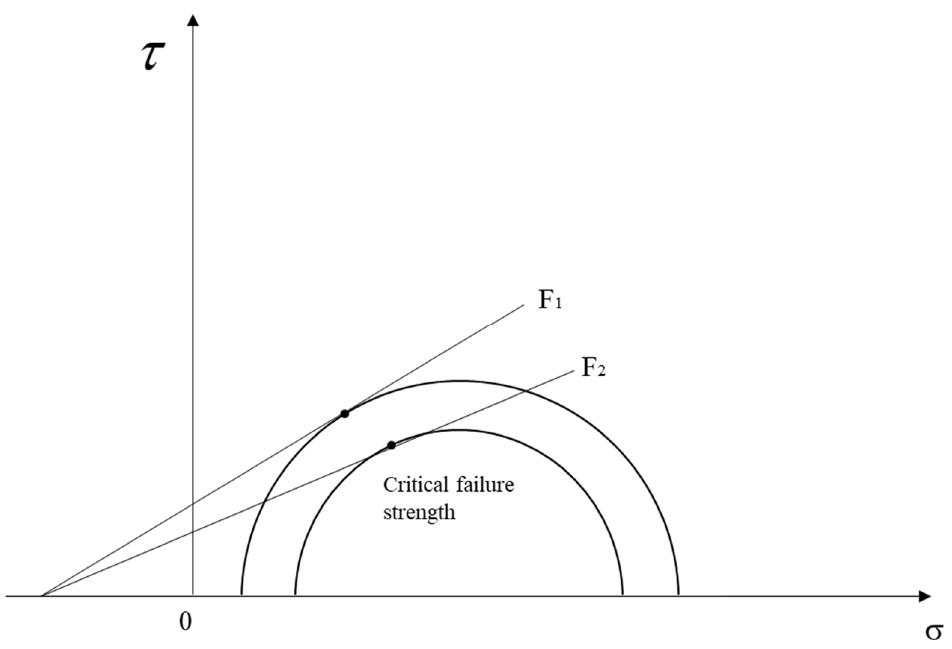
Figure 8. The change in strength reduction failure